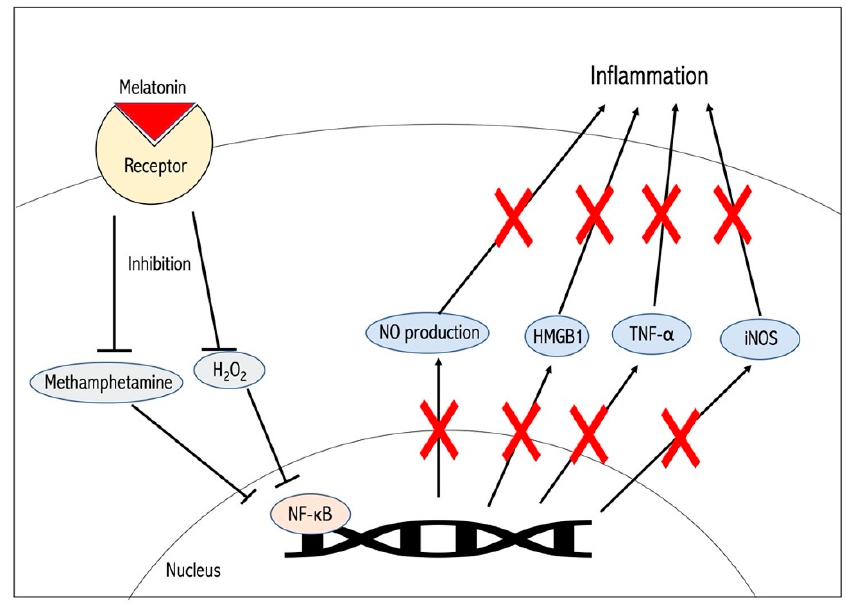
Figure 2. Melatonin’s Intracellular Signaling. Melatonin initiates a cellular pathway that inhibits Methamphetamine and hydrogen peroxide in the cell, resulting in the attenuation of inflammation and oxidative stress.